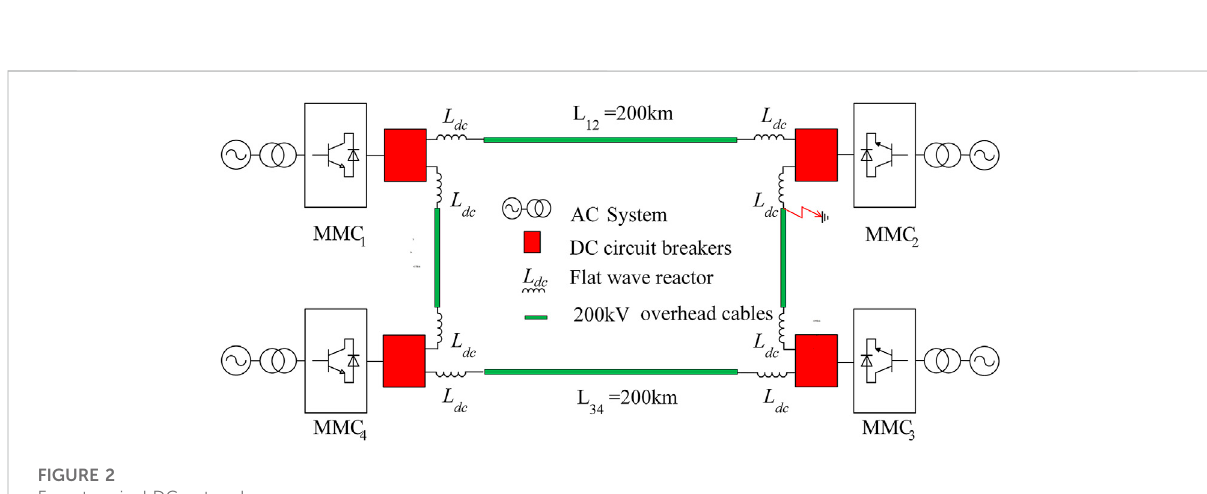
FIGURE 2 Four-terminal DC